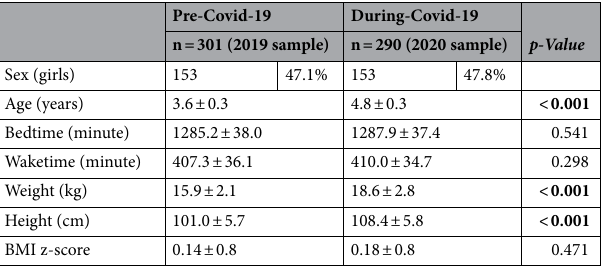
Table 1. Descriptive characteristics of participants. Bold values indicate a factor of significant relevance.